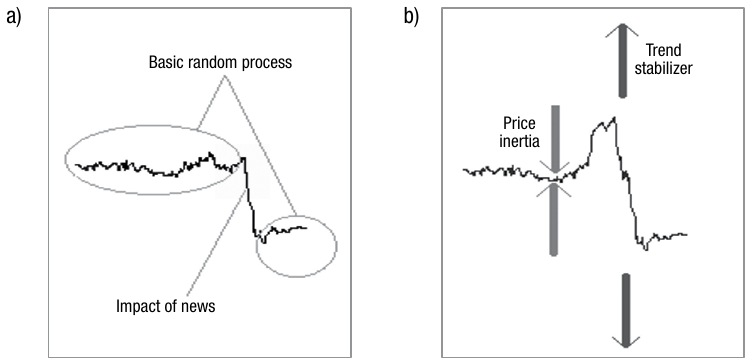
Fig. 2. Impact of important economic news (a), price inertia, trend stabiliser feedback impact (b) Source : created by